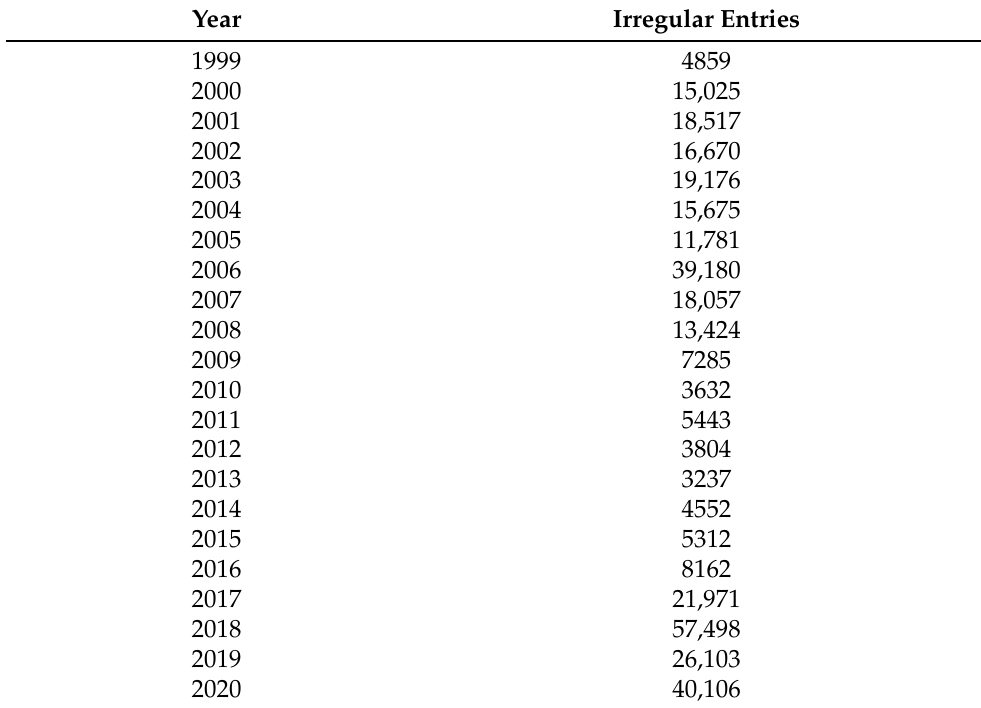
Table 1. Incoming Irregular